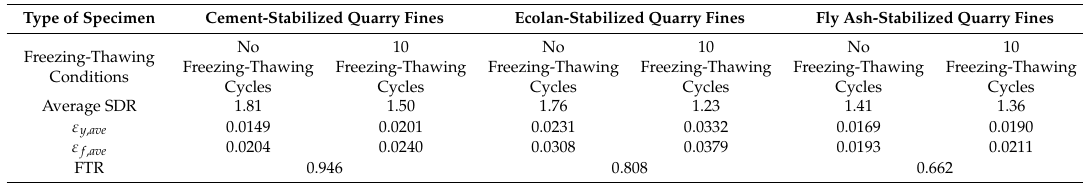
Table 4. Indicators to evaluate e ff ects of freeze-thaw